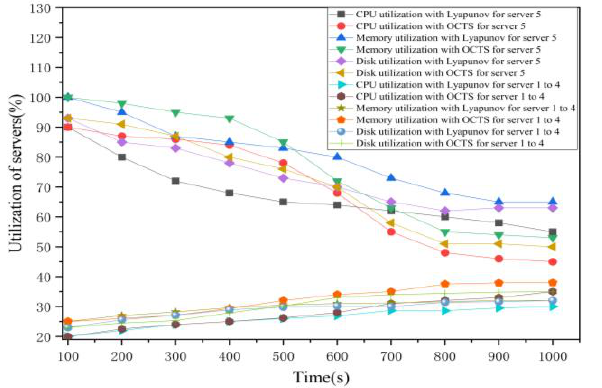
Figure 7. The edge server usage comparisons between Lyapunov optimization and our proposed method.